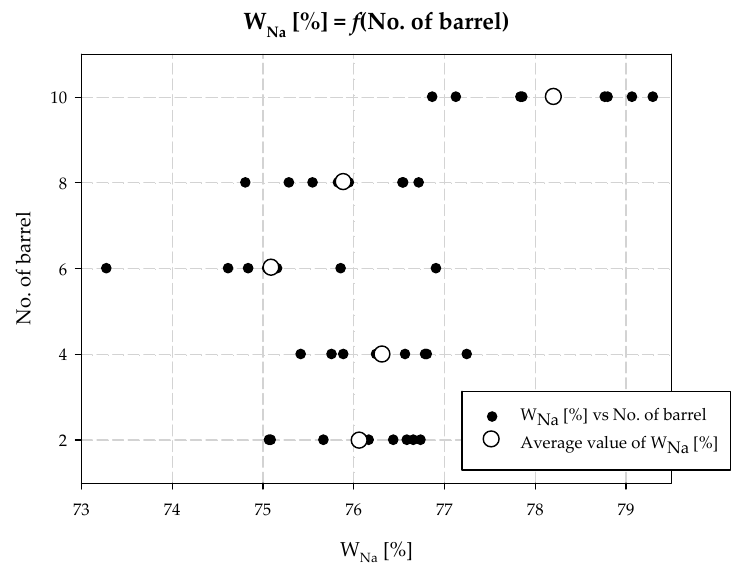
Figure 5. Carbonization yield and AAB dosing place (No. of barrel). As can be seen from reaction (1.1), the amount of NaHCO 3 formed in the soda process is equivalent to the amount of the resulting NH 4 Cl. However, part of the resultant NaHCO 3 , determined by the solubility product under given conditions, is found in solution. The amount of precipitated NaHCO 3 in the form of precipitate will, therefore, be